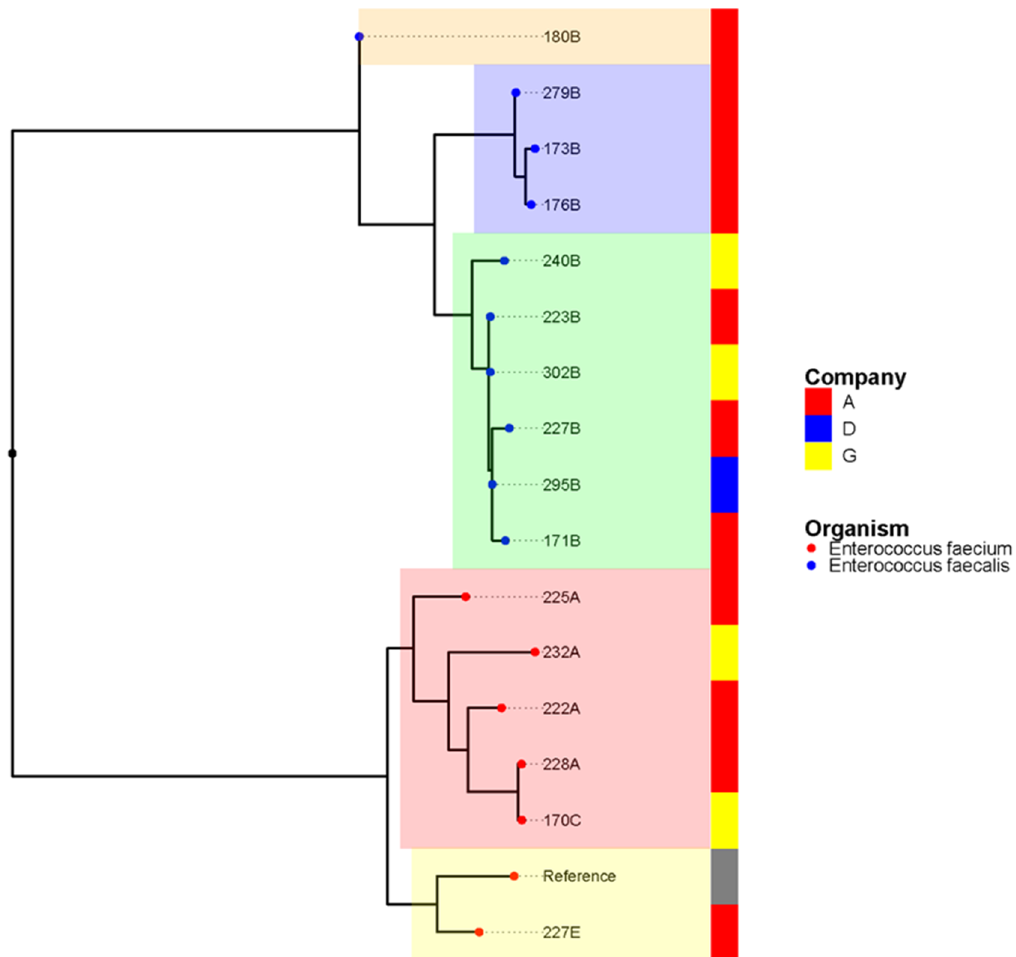
Figure 1. Maximum-likelihood phylogenetic rectangular tree based on single nucleotide polymor- phisms (SNP). The tree contains 10 E. faecalis (blue tip color) and 6 E. faecium (red tip color) isolates from retail chicken meat collected in the UAE. The species influenced the clustering among the isolates, with two clusters identified in E. faecium and three in E. faecalis . No clustering was found based on the processing companies (A, D,